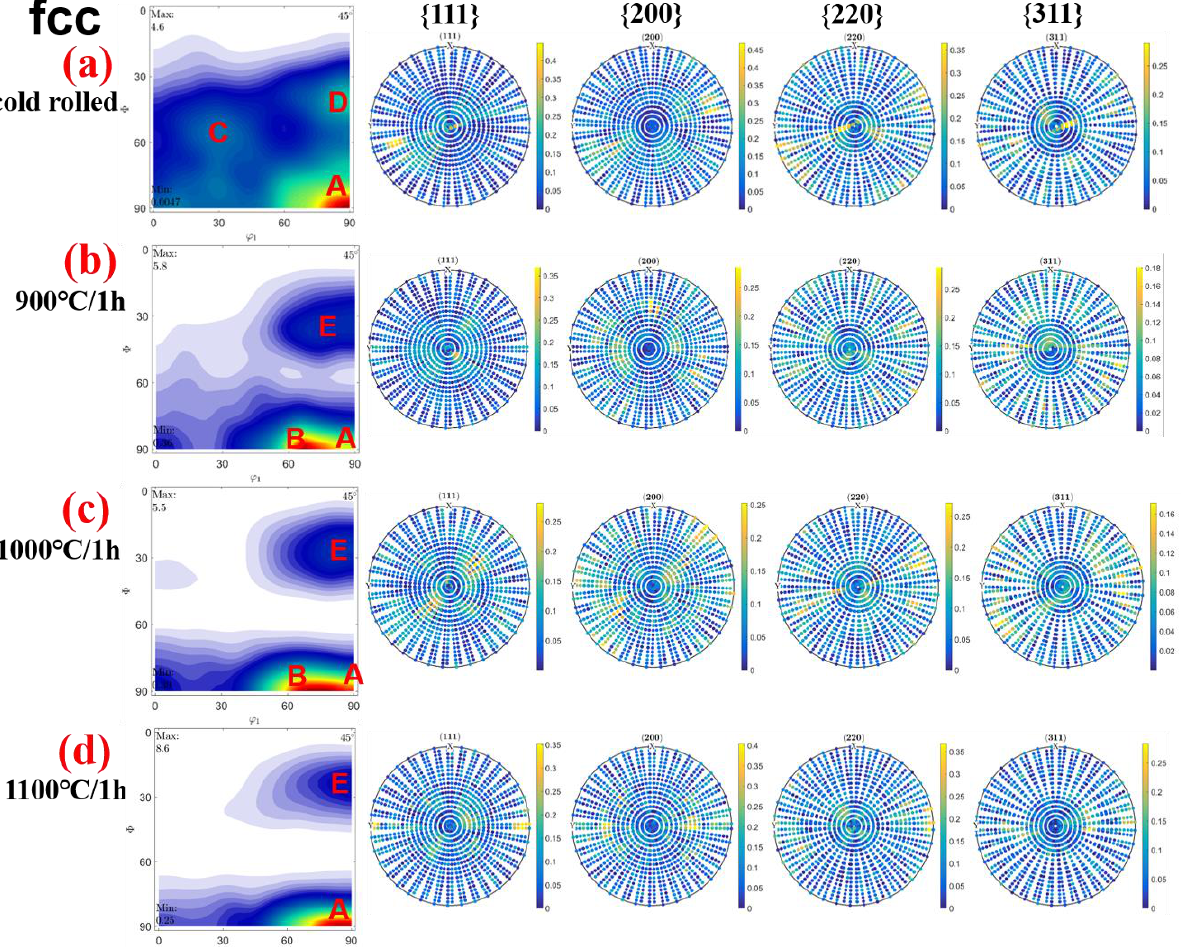
Figure 4. The orientation distribution functions (ODFs) and the difference between the calculated ODFs and the raw data in the pole figure of the fcc phase in the HEA, annealed at ( a ) cold-rolled, ( b ) 900 °C/1 h, ( c ) 1000 °C/1 h, and ( d ) 1100 °C/1 h. Note that φ 2 = 45°.